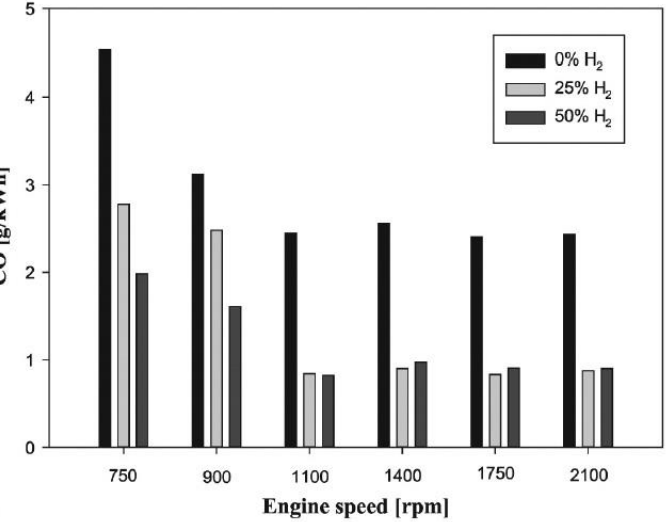
Figure 12. Reducing of CO emissions using hydrogen fuel in diesel engines [78].